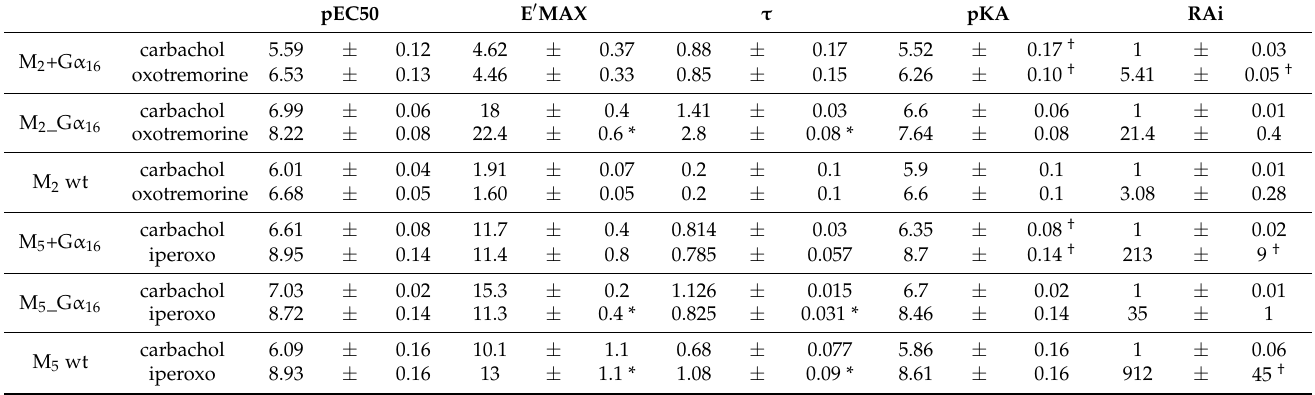
Table 3. Comparison of parameters of functional response of variants of M 2 and M 5 receptor. Parameters of agonist-induced functional response EC 50 and E ´ MAX were obtained by fitting Equation (6) to data from measurement of the accumulation of inositol phosphates. Operational efficacy τ , agonist equilibrium dissociation constant K A and agonist relative intrinsic activity RA i were calculated according to Equations (6)–(8), respectively. EC 50 and K A are expressed as negative logarithms. Values of system E MAX are (30.7 ± 0.603 for M 2 _G α 16 ; 29 ± 3 for M 5 _G α 16 ; 5.8 ± 0.4 for M 2 + G α 16 ; 21 ± for M 5 + G α 16